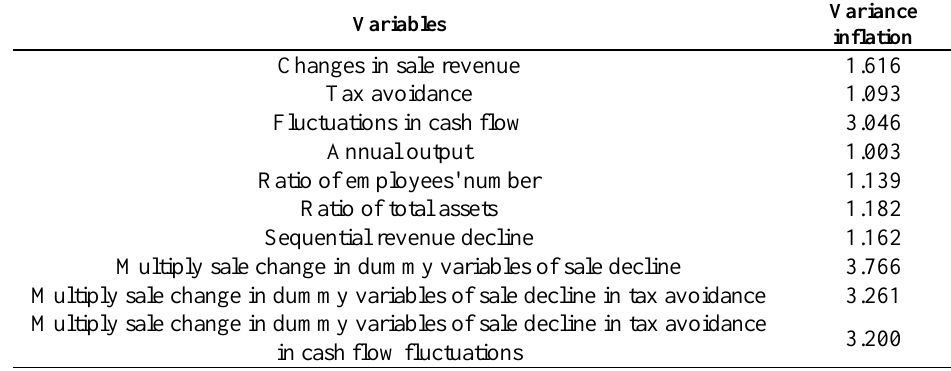
Table 3. Results of tolerance and variance inflation statistics